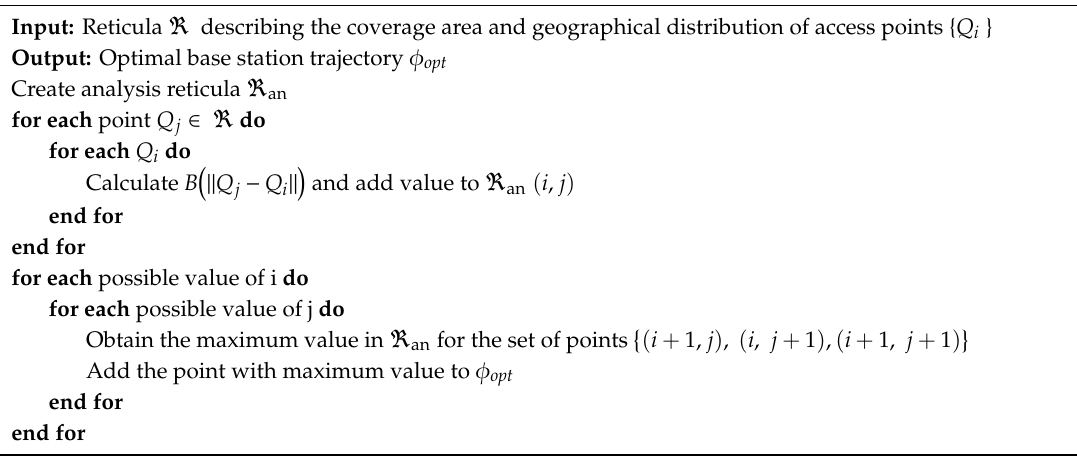
Algorithm 2. Mobile Base Station Path Calculation Using DTW